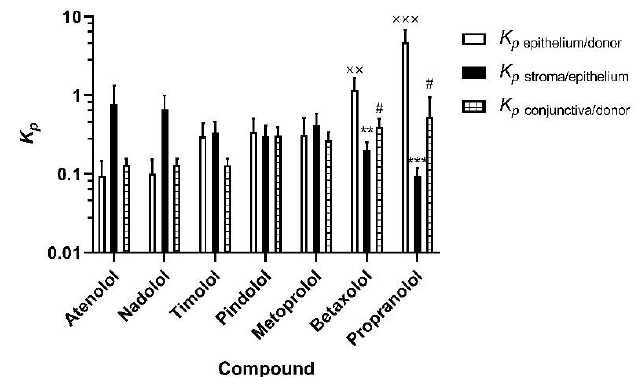
Figure 3. Estimated epithelium/donor solution, stroma/epithelium, and conjunctiva/donor solution